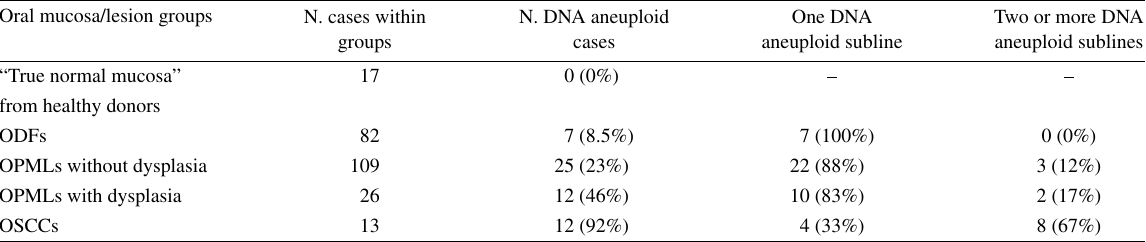
Presence of single and multiple DNA aneuploid sublines among 5 different groups of oral